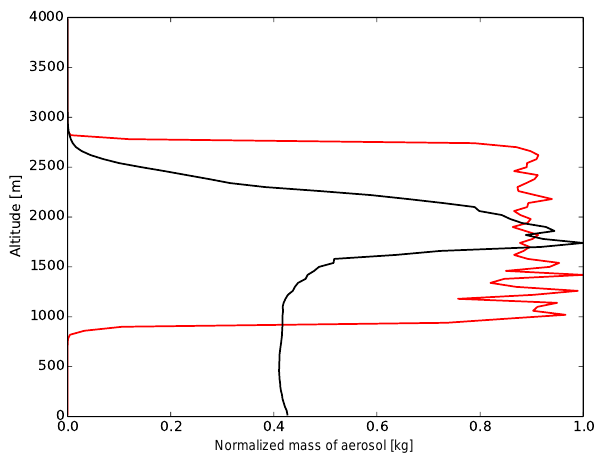
Figure 3. Final vertical profiles for two representative SAM- TOMAS simulations after 4h, normalized to individual aerosol load and averaged horizontally across the domain. The black profile shows a simulation where the aerosol mixed through the bound- ary layer to the ground with some aerosol still trapped in a stable emission layer, while the red profile shows a simulation where the aerosol plume is still stable at the emission injection